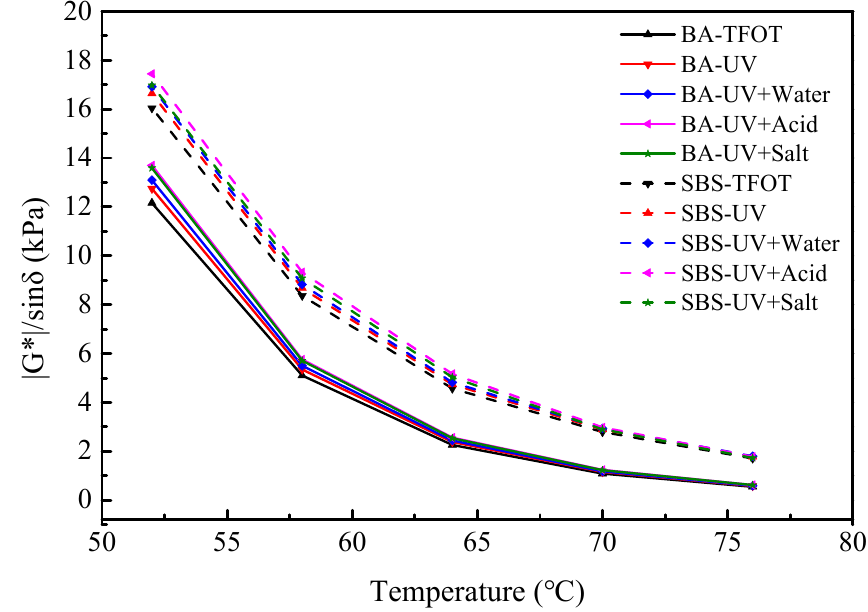
Figure 3. Rutting factors of bitumen before and after UV aging in different environments.